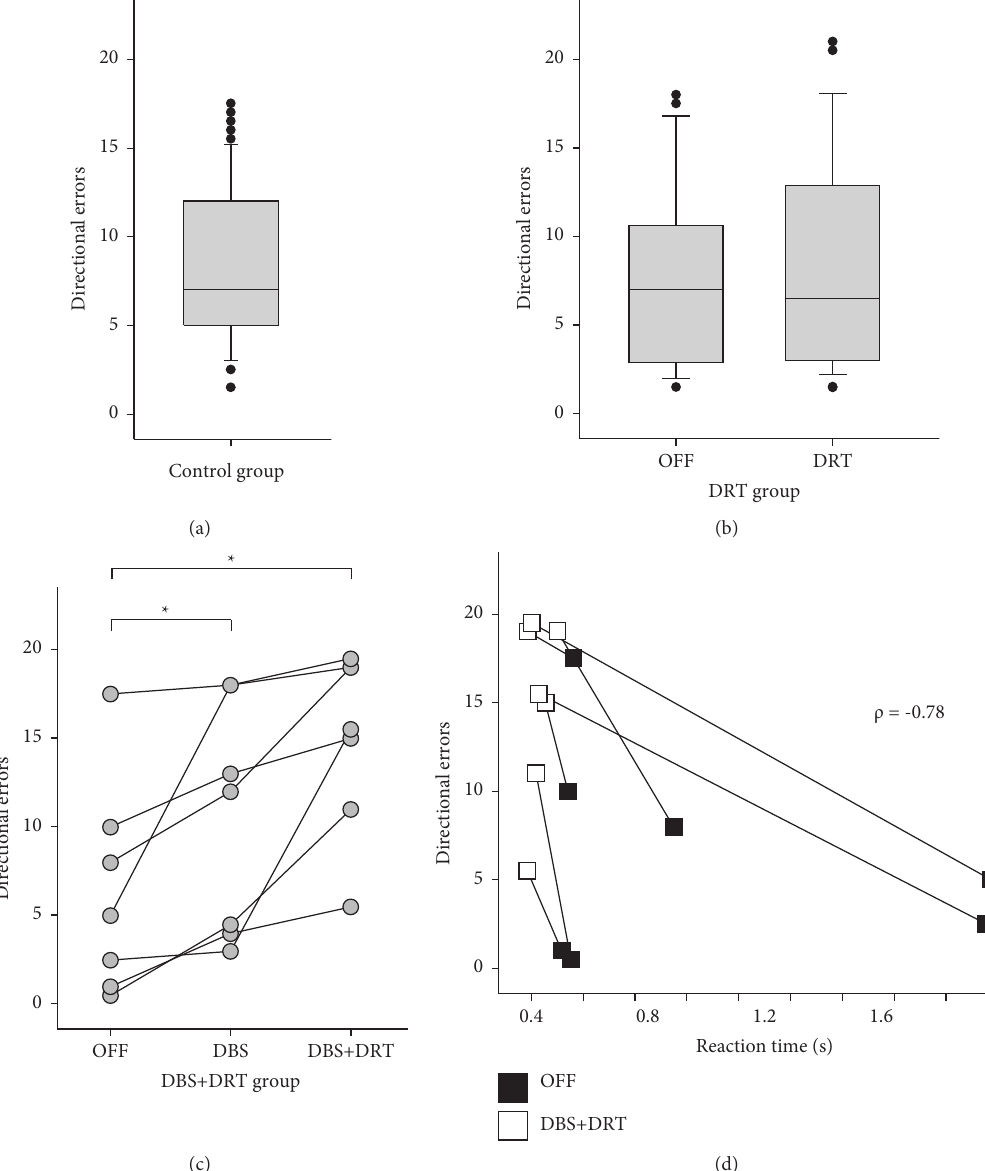
Figure 5: Direction errors during RVGR. (a). Control group. (b) DRT group. There was no effect of DRT on directional errors. (c) DBS+ DRTgroup. Total directional errors were increased with DBS and DBS +DRT ( ∗ P < 0 . 05). (d). The change in directional errors versus the change in reaction time for off therapy and DBS+DRT. The changes in directional errors with DBS+DRT in were correlated to the changes in mean reaction time ( P � 0 .